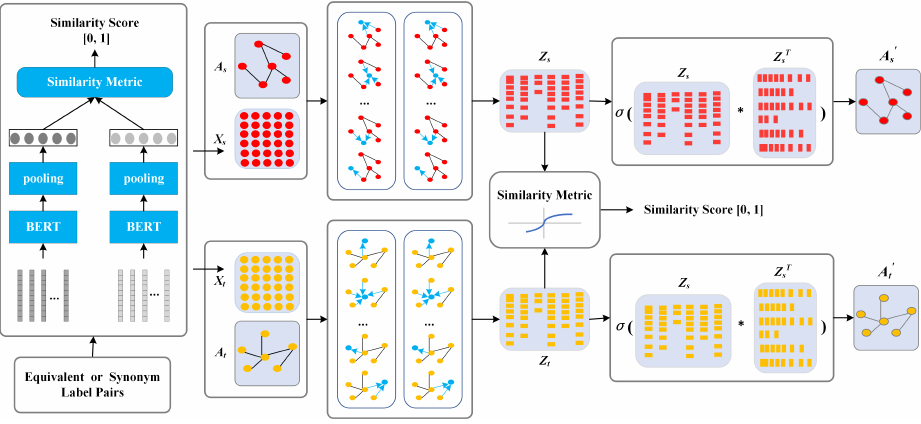
Figure 2. Architecture of ontology attentional